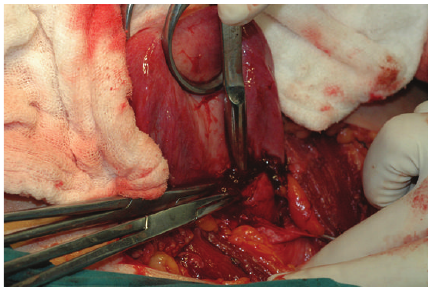
Figure 3: The guide of a number 8 Hegar dilator inserted from the incisionsitetolocalizethetransversevaginalseptum.Thefigurealso shows uterus and bilateral tubes normal in size and shape for the age of the